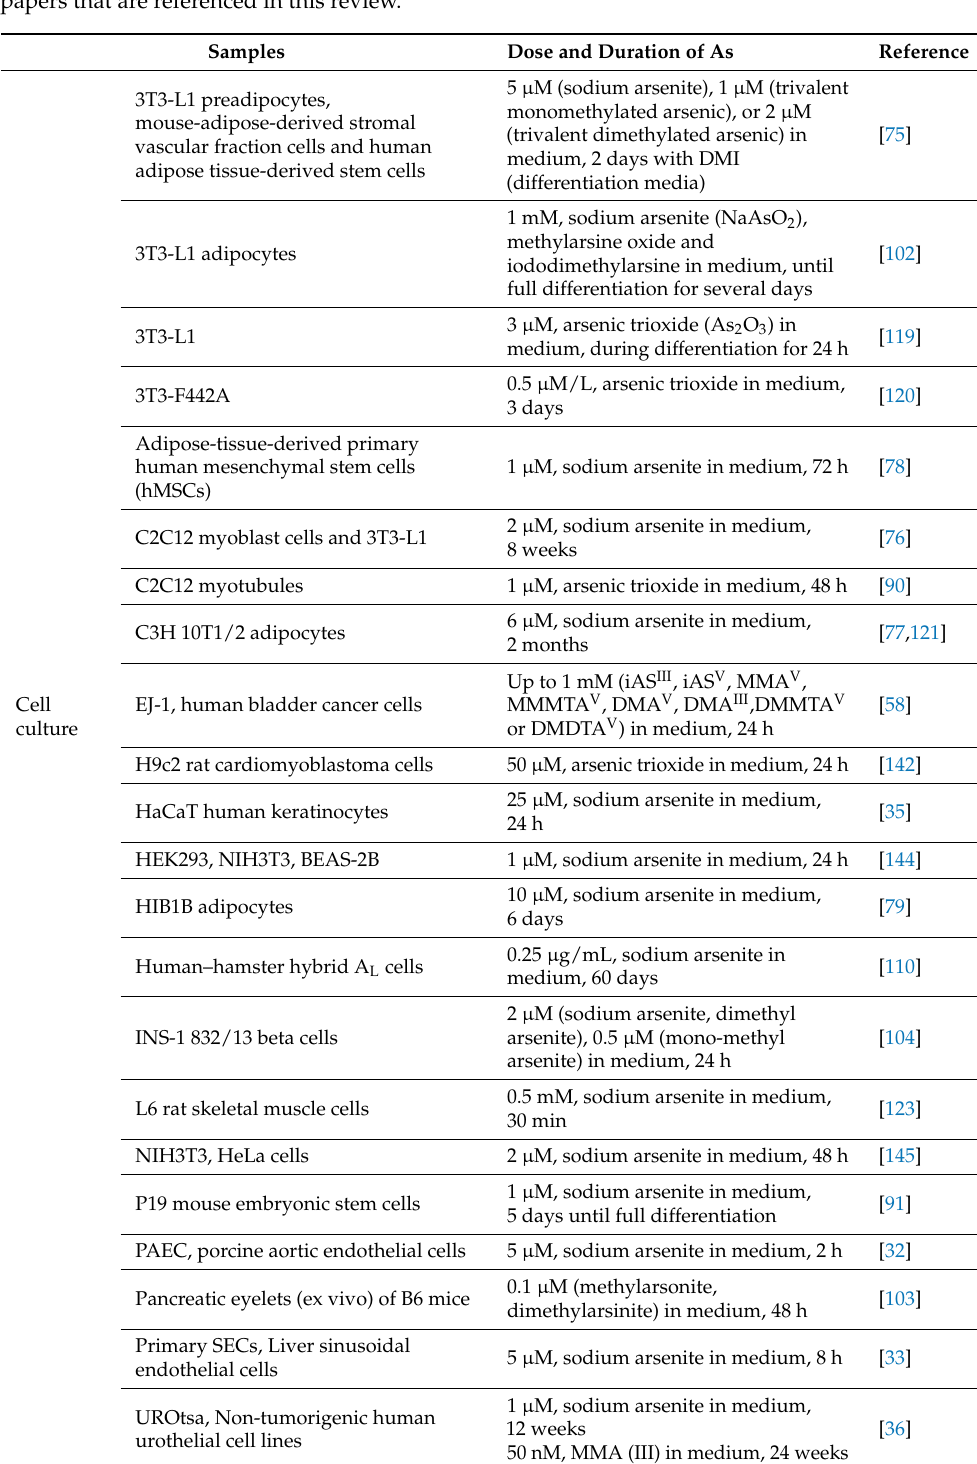
Table 1. Summary of the maximum dose and duration of As treated or administered in the research papers that are referenced in this